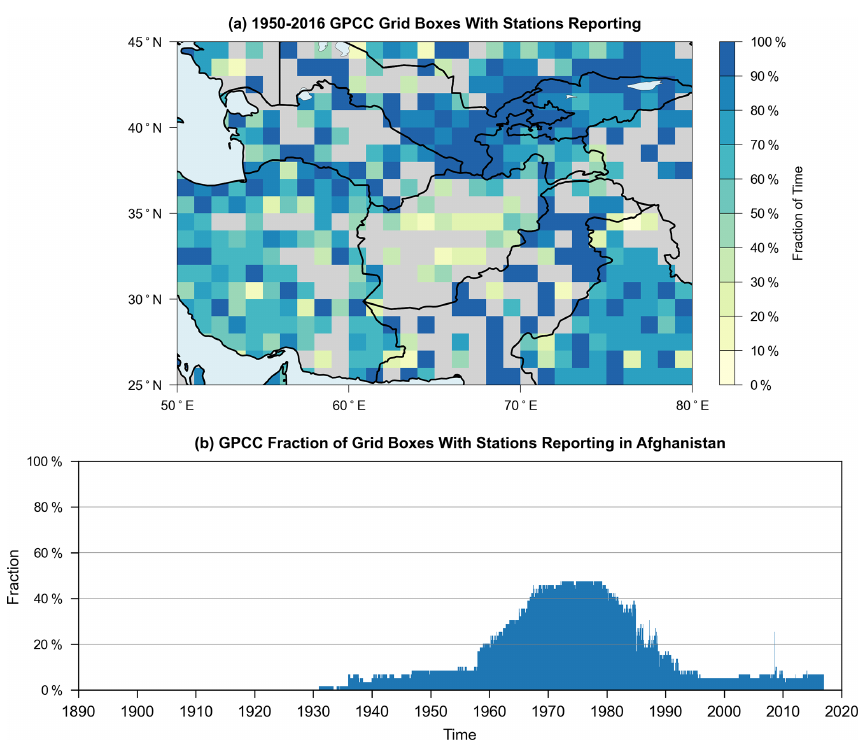
Figure 2. (a) Station data availability underlying the GPCC version 6 dataset, for the 1950–2016 period, on the 0.5 ◦ resolution grid over Central Asia. (b) Fraction of grid cells with number of stations used as input to the GPCC rainfall dataset in Afghanistan from